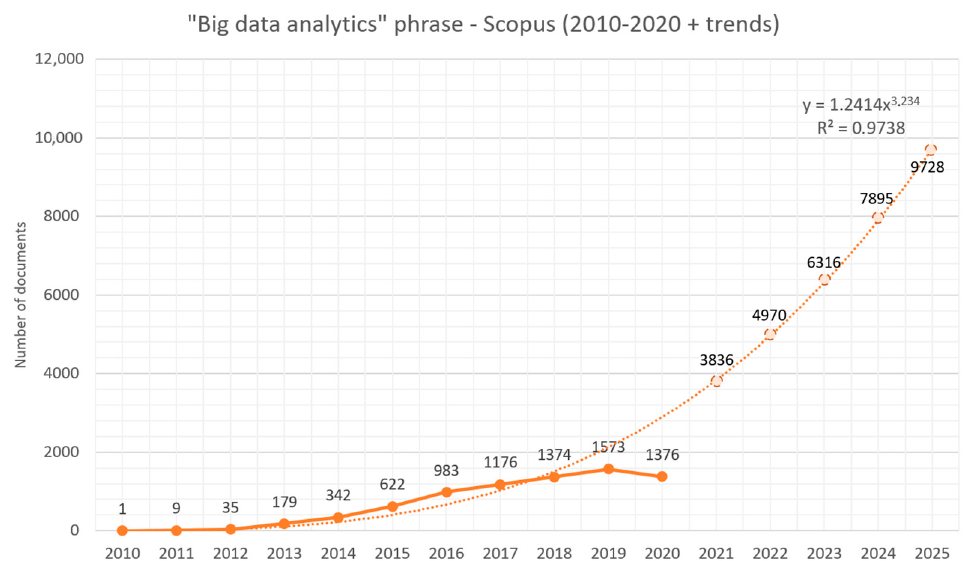
Figure 14. Time series for articles from the Scopus database corresponding to the phrase “big data analytics” (for the years 2010–2020) with the power trendline (with the highest value of R 2 ) and forecasted values (absolute) for the years 2021–2025. Table 3. Equations of trendlines for the Scopus dataset corresponding to the expression “big data mining” (for the years